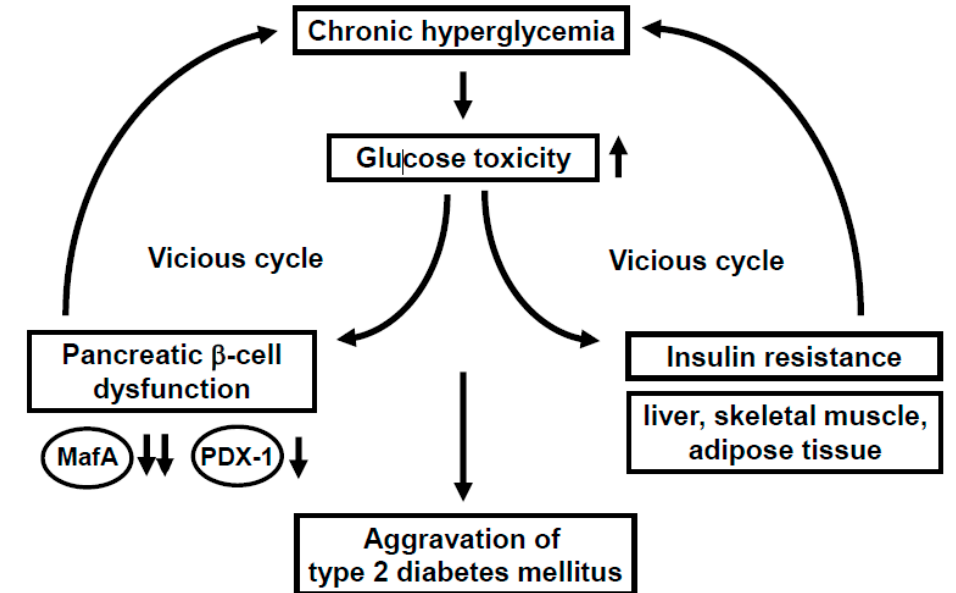
Figure 1. Involvement of glucose toxicity in pancreatic β -cell dysfunction and insulin resistance. Under diabetic conditions, pancreatic β -cell function is gradually debilitated by the burden of glucose toxicity. In addition, insulin signaling in insulin target tissues (liver, skeletal muscle, and adipose tissue) is weakened by the burden of glucose toxicity, leading to the development of insulin resistance. Such debilitation of the β -cell function and development of insulin resistance bring about a vicious cycle and finally lead to further aggravation of type 2 diabetes mellitus.